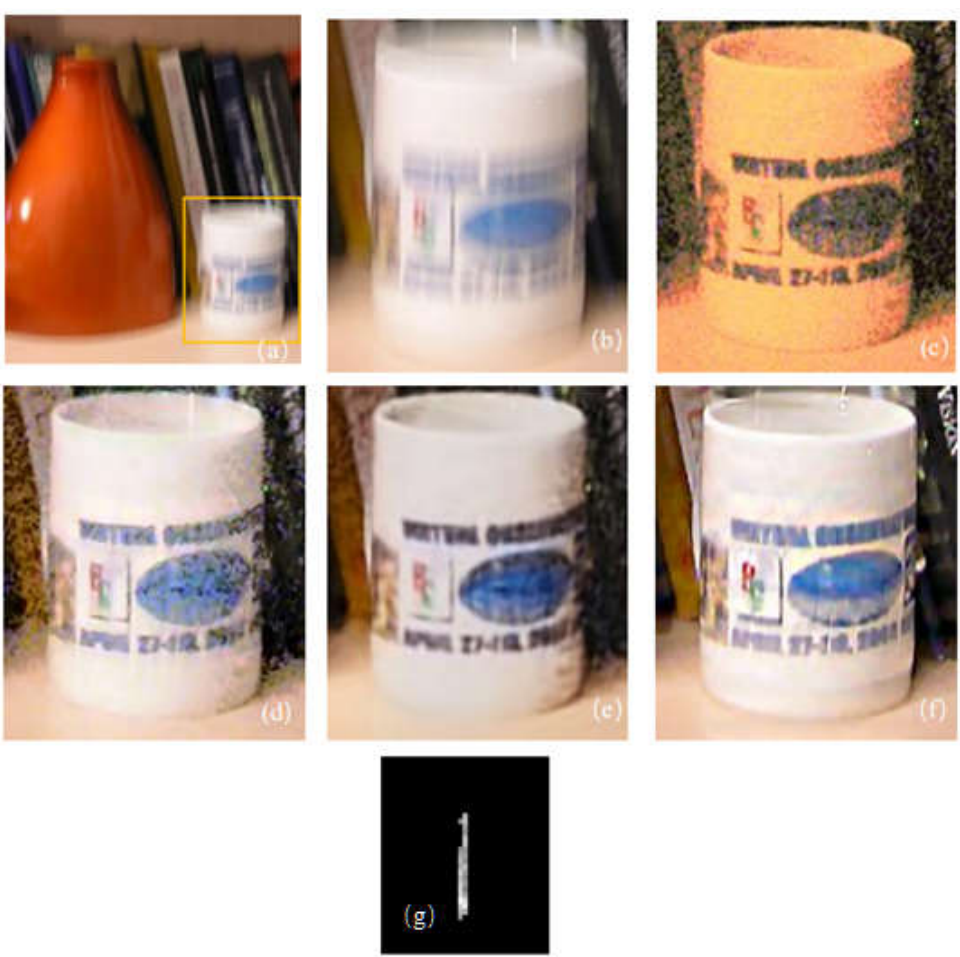
Figure 8. Real image restored experiment; ( a ) blurred image; ( b ) blurred image part; ( c ) Scheme 11. ( e ) algorithm restored image in [17]; ( f ) this paper; ( g ) kernel by proposed.